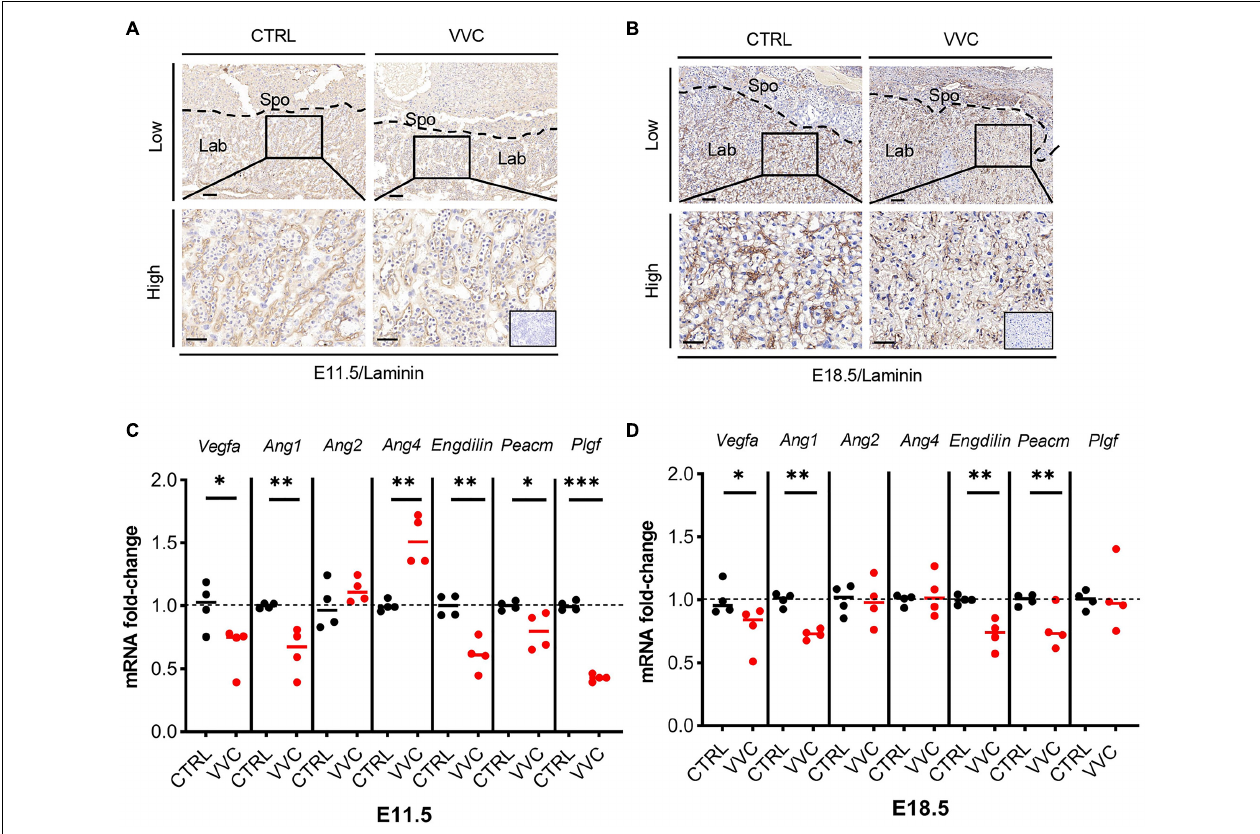
FIGURE 7 | Effect of vaginal C. albicans infection on the labyrinth vascularization of placenta. (A,B) Laminin immunohistochemical staining of mice placentas from the VVC group and control group at E11.5 (A) and E18.5 (B) . Low magnification scale bar = 100 µ m, high magnification scale bar = 50 µ m. Inserted image shows immunostaining of a negative control. Spo, spongiotrophoblast; Lab, labyrinth. (C,D) Relative expression of the angiogenesis-related genes ( Vegfa , Ang1 , Ang2 , and Ang4 ), vascular endothelial cell markers ( Endoglin and Pecam ), and Plgf in the placenta from the VVC group and control group at E11.5 (C) and E18.5 (D) . Four samples of each group were used. The experiment was performed in triplicate wells and repeated three times. Data are presented as mean ± SD. Unpaired t -test was used for two-group comparisons. * p < 0.05, ** p < 0.01, *** p < 0.001 for VVC vs.